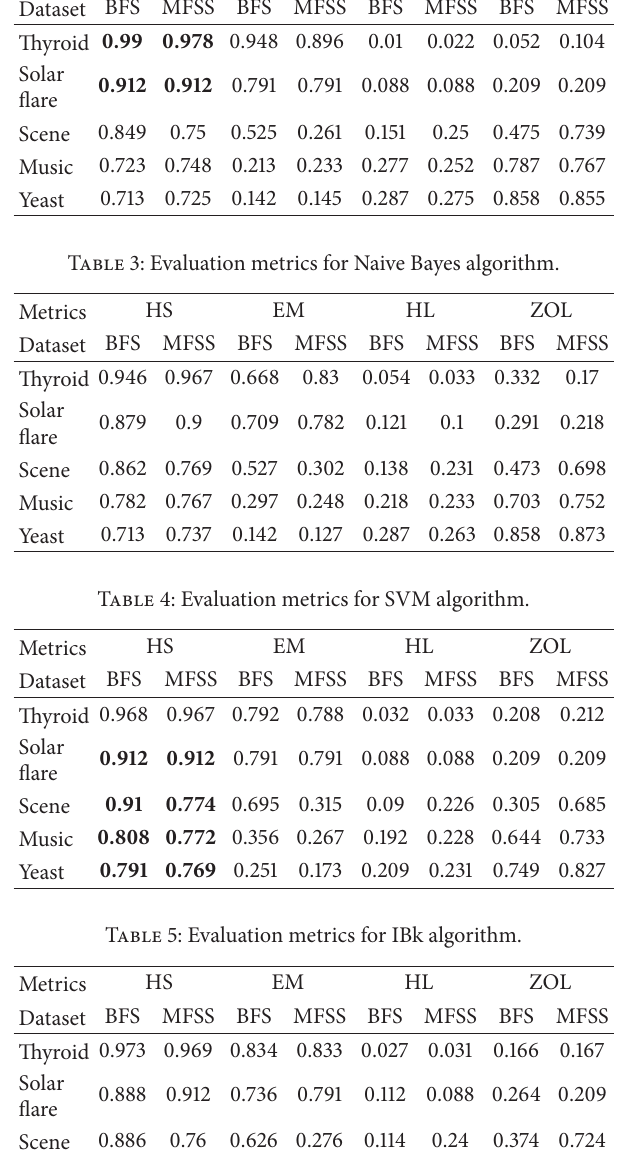
Table 1: Details of the dataset used in experiments. Dataset